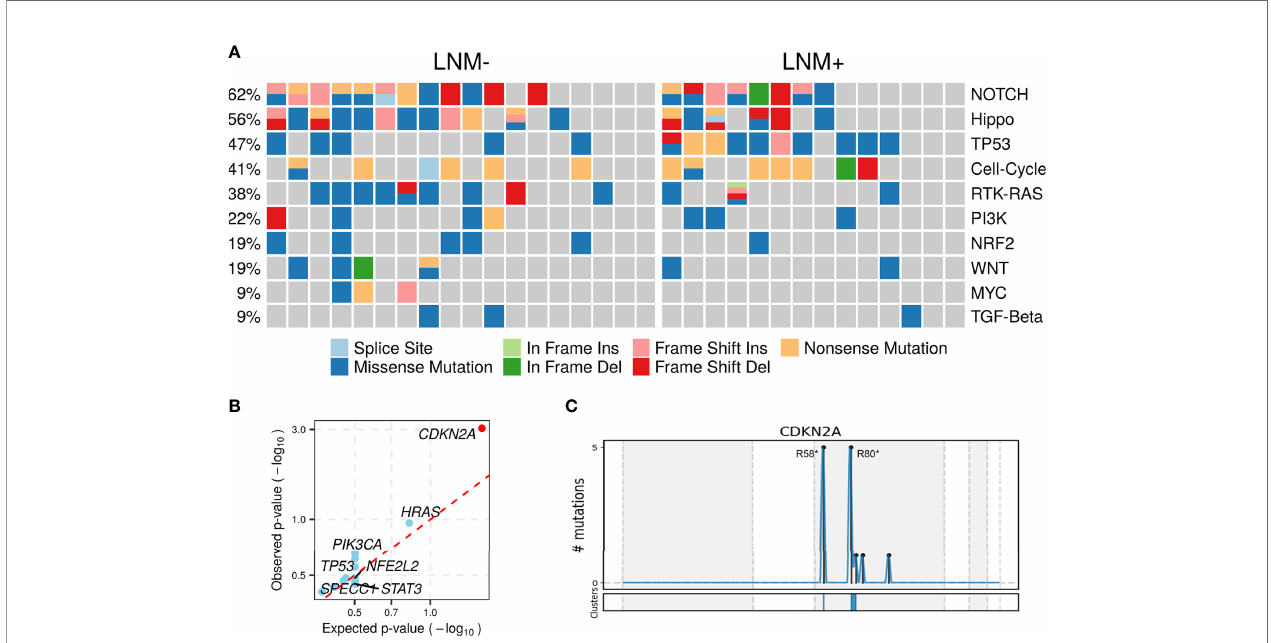
FIGURE 2 | Altered pathways and diver mutant in penile carcinoma. (A) The frequencies of ten common cancer-related pathways altered in 32 PSCC patients, (B) PSCC candidate driver genes identi fi ed by OncodriveCLUSTL. Signi fi cant gene (observed p-value < 0.01) is highlighted with red circle. (C) Distribution of mutations across CDKN2A region in 32 PSCC patients. The mutations, mainly two hotspots labeled in the fi gure, are enriched in two clusters (shown at the bottom) that span 1 base and 16 bases respectively.